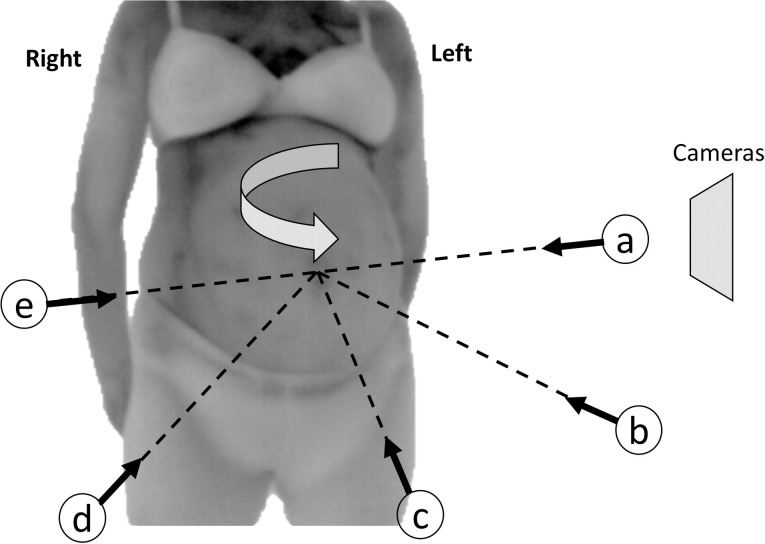
The five viewpoints.